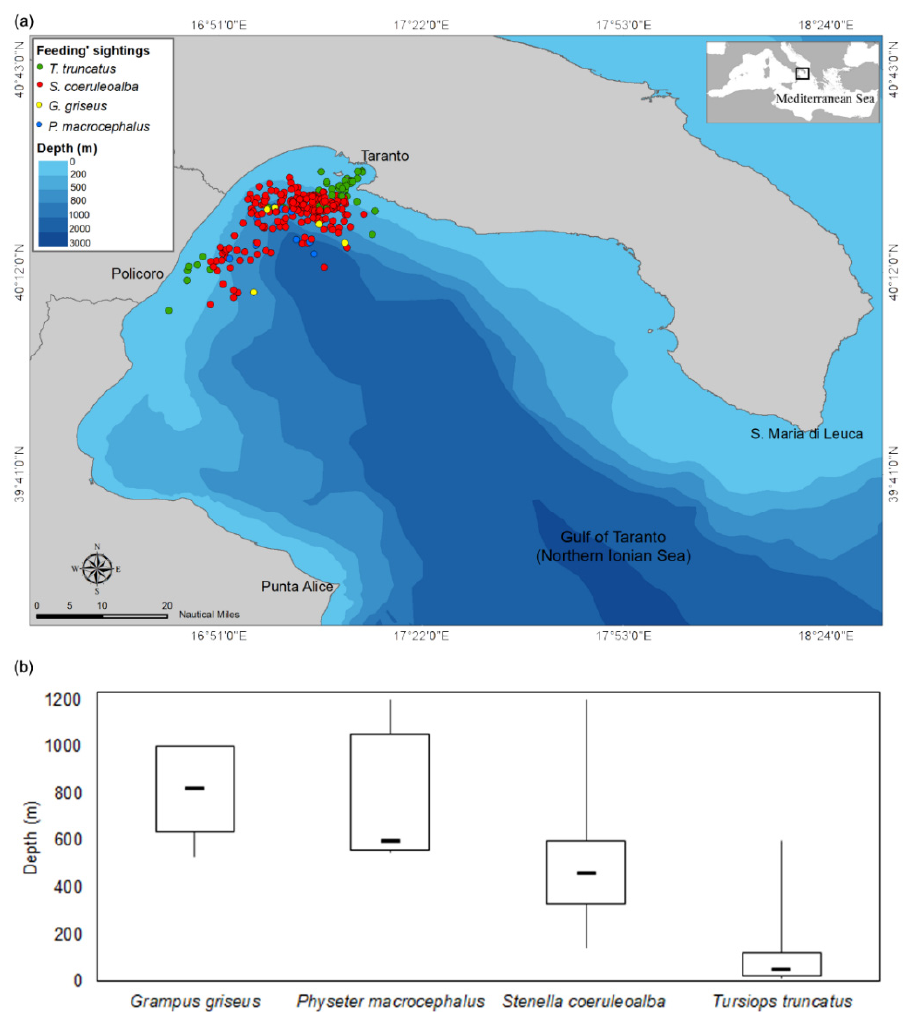
Figure 2. ( a ) Spatial distribution of the sightings of feeding activity. ( b ) Boxplot of bathymetric values recorded in the study area during the period 2009–2020. The boxplots show the median (midline), quartiles (box limits) and minimum and maximum values (whiskers).